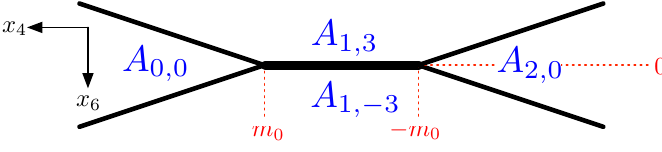
Figure 5. The blue letter A ( m ) indicates the largest A ( m ) in the region. The black solid lines are k;l k;l the boundaries of those regions and give the 5-brane web in the decompacti(cid:12)cation limit of the E 1 curve in Region 2